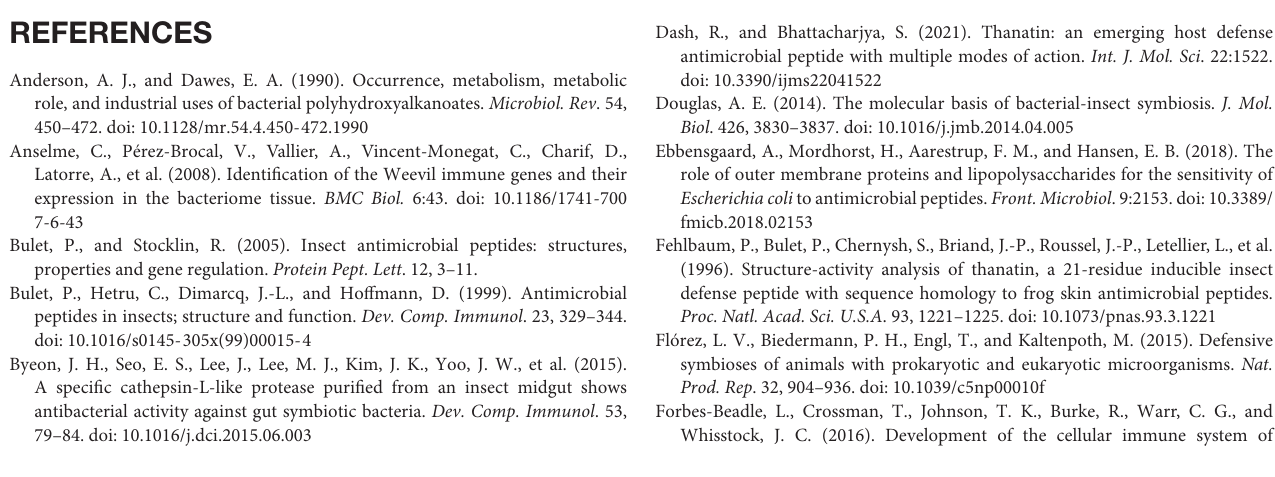
Supplementary Figure S1 | The antibacterial activity of (i) thanatin KRL isoform and (ii) thanatin KRM isoform against (A) E. coli K12 and S. marcescens Db11, (B) Cultured Burkholderia and symbiotic Burkholderia cells. CFUs were normalized by AMP-untreated CFUs set to 100%. Data are expressed as mean ± SD ( n = 3). Data are representative of three independent experiments. Supplementary Figure S2 | Survival rates of R. pedestris upon systemic injection with the LPS mutant strains. Data are expressed as mean ± SD ( n = 10). Data are representative of three independent